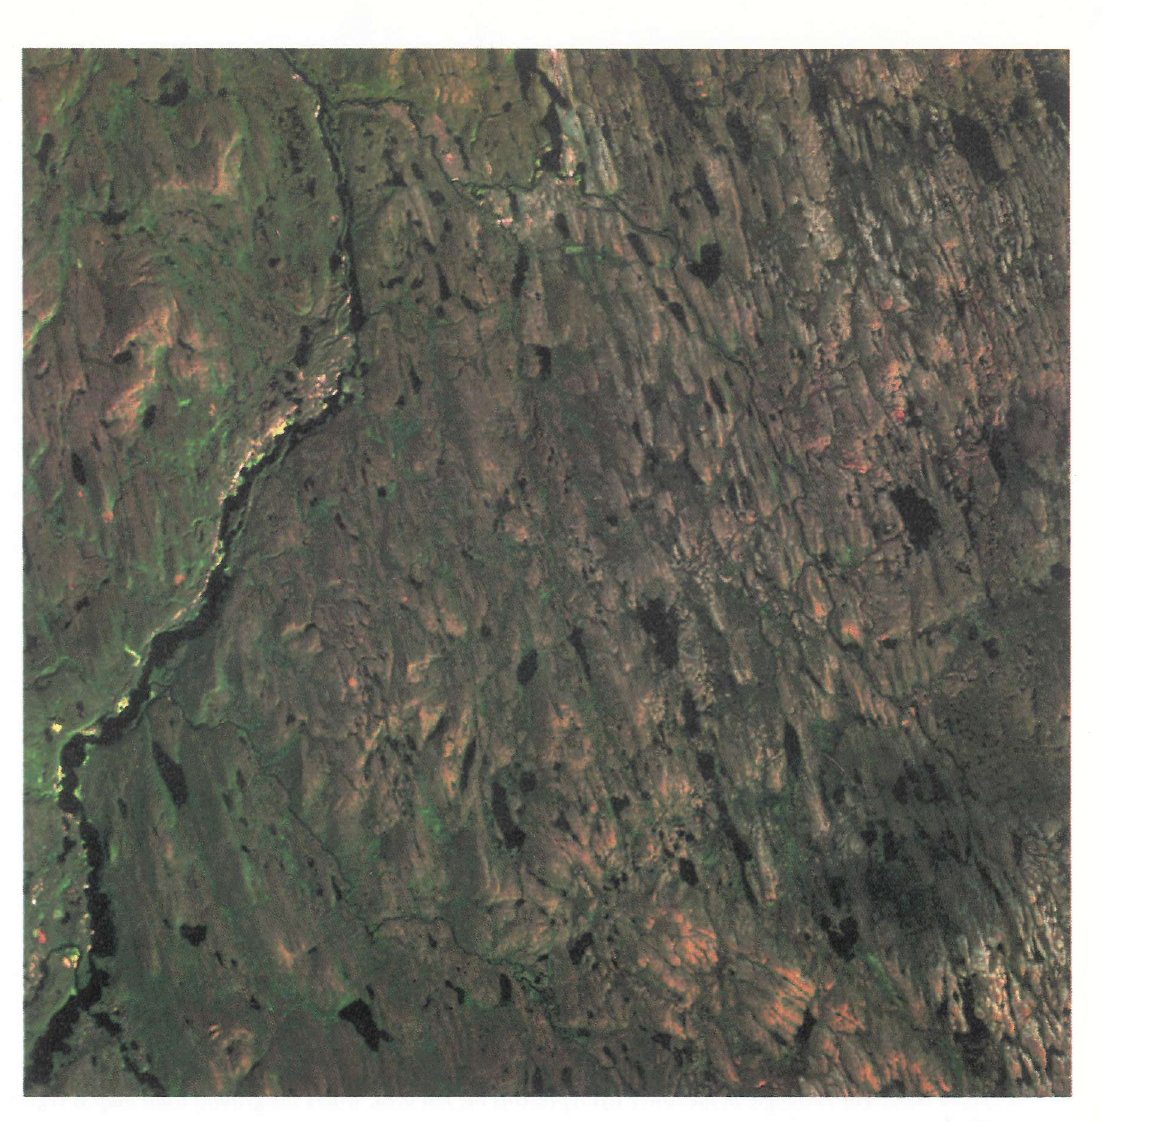
Figur 2. TM - kanalkombinasjonen 5/4/3 (RGB) over Kautokeino-området, geometrisk korrigert og transfor mert over til en U TM kartprojeksjon. Bildet er også lineært kontrastforbedret for å få fram detaljer i bildet. I bildet framkommer lavheier i grå/rød/brun farge, myr i rød-brun farge og skog i grønne nyan ser. Landbruksområder vises i gule og røde fargenyanser, mens veier og sandtak vises i røde farger. I nederste høyre hjørne blir bildet forstyrret av noen skyer. Fig. 2. TM - bandcombination 51413 (RGB) over Kautokeino area, registred to UTM projection. The image is contrast stretched (linear stretching) for visual inspection and feature recognition. Dry shrub and fresh shrub (both types with lichen) are represented in grey, red and brown colours, wet shrub and mires in dark red-brown colours and forests in green colours. Agricultural areas are represented in yellow-red co lours, roadsystems are to be seen in red colours. The area in lower right part of the image is partly covered with